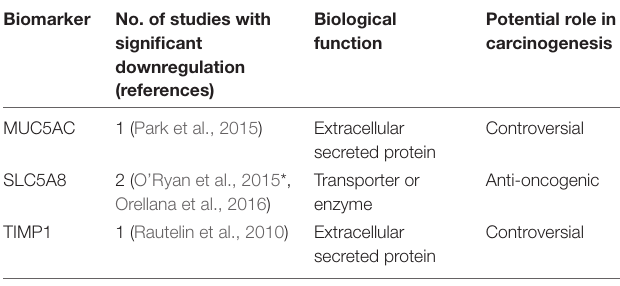
TABLE 2 | Biomarkers underexpressed in H. pylori infected children in at least one study included in this review. Biomarker No. of studies with significant